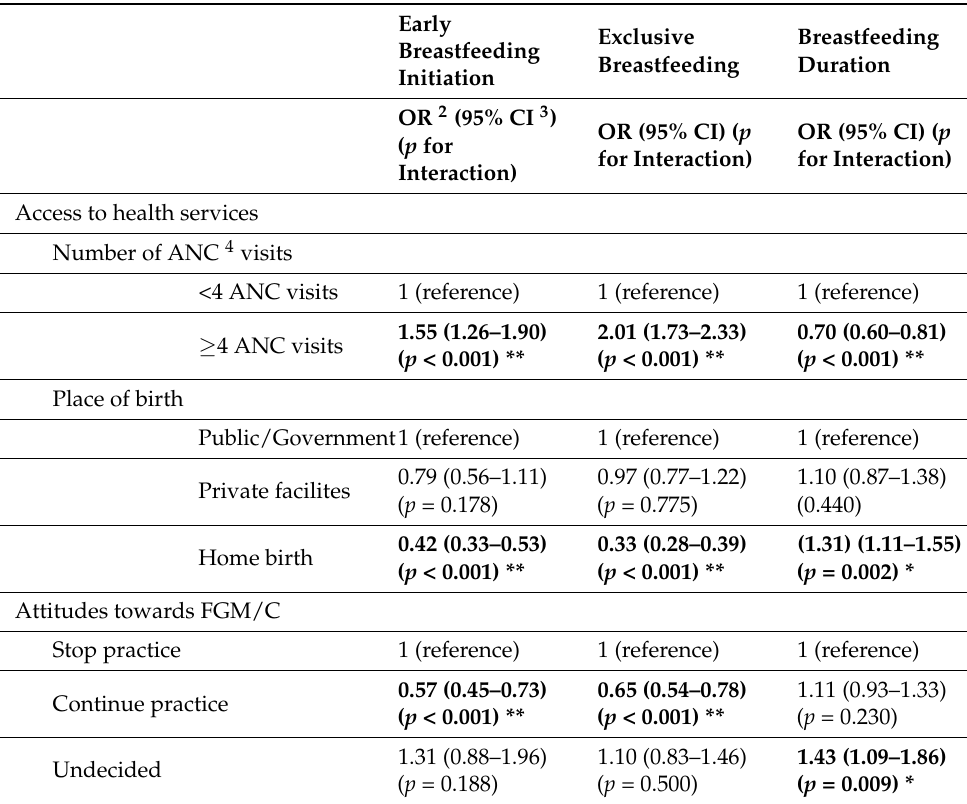
The modifying effects of access to healthcare services on FGM/C 1 and breastfeeding